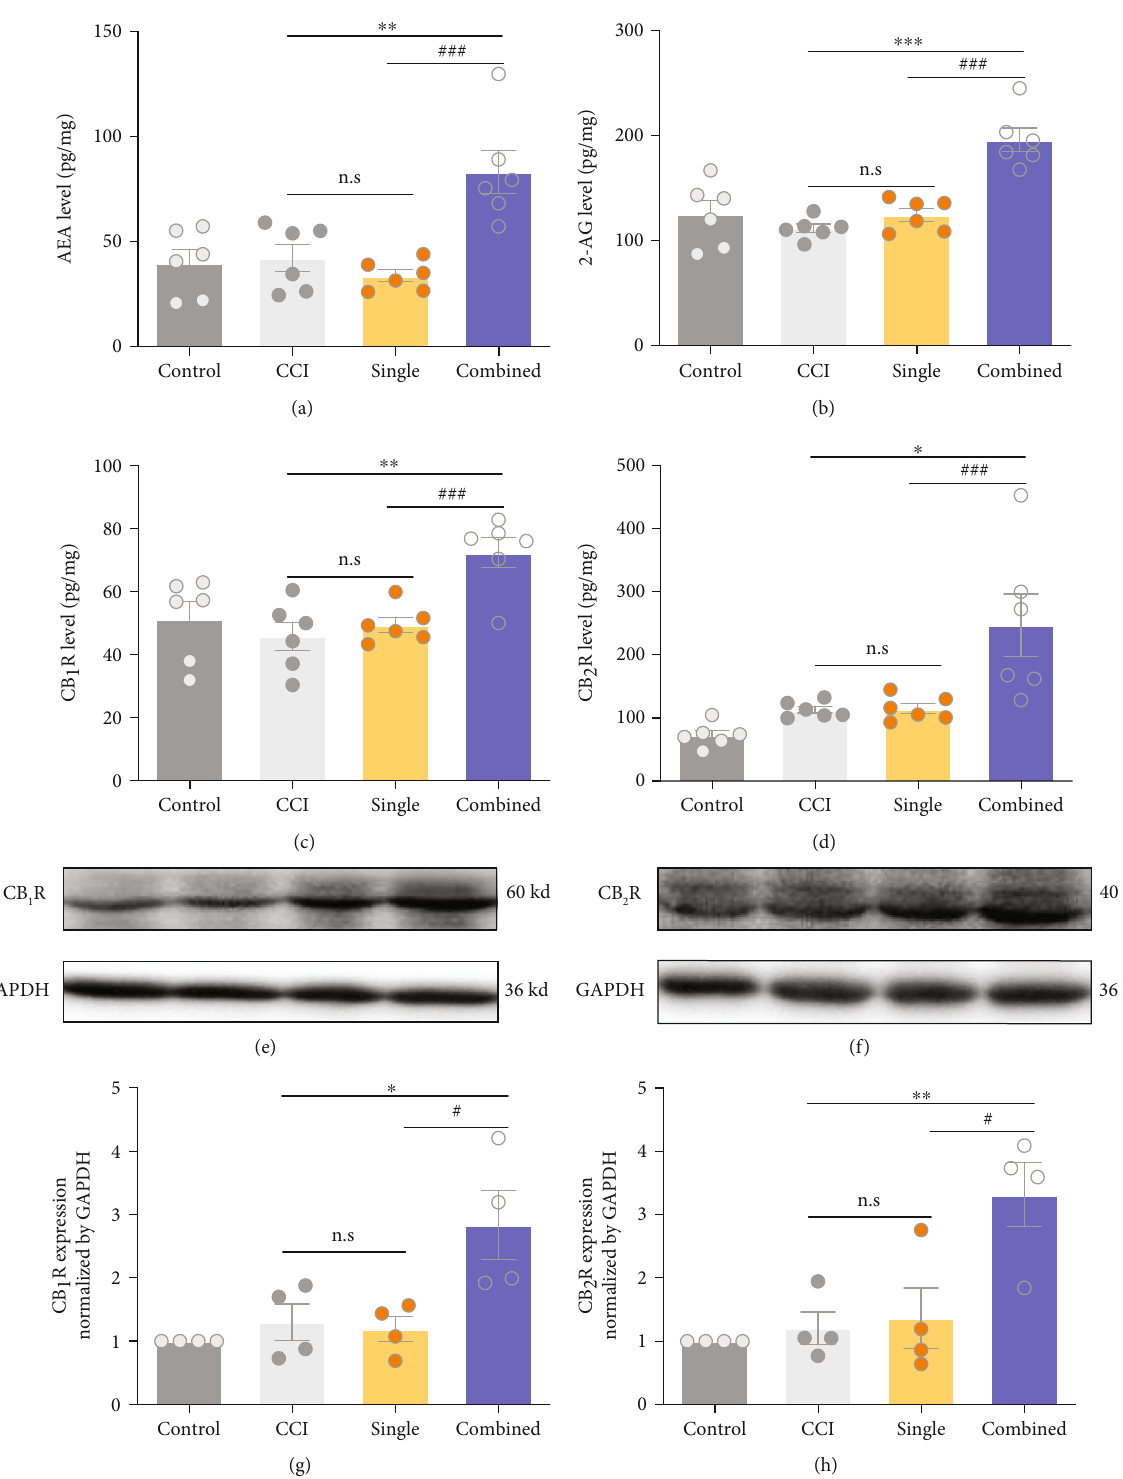
Figure 5: Combined-acupoint rather than single-acupoint EA activated the endogenous cannabinoid (eCB) system. ELISA assay revealed that combined-acupoint EA but not single-acupoint EA increased the release of AEA (a) and 2-AG (b) after 6 days ’ EA treatment. ELISA assay demonstrated that the expression of CB (c) and CB (d) receptor was only upregulated in combined-acupoint EA-treated 1 2 group. The western blot analysis con fi rmed combined-acupoint EA but not single-acupoint EA increased the expression of CB and CB (f, h) in the spinal cord. Student ’ s unpaired t -test. All data are mean ± SEM , ∗ P < 0 : 05 , ∗∗ P < 0 : 01 , ∗∗ P < 0 : 01 vs. combined; 2 #